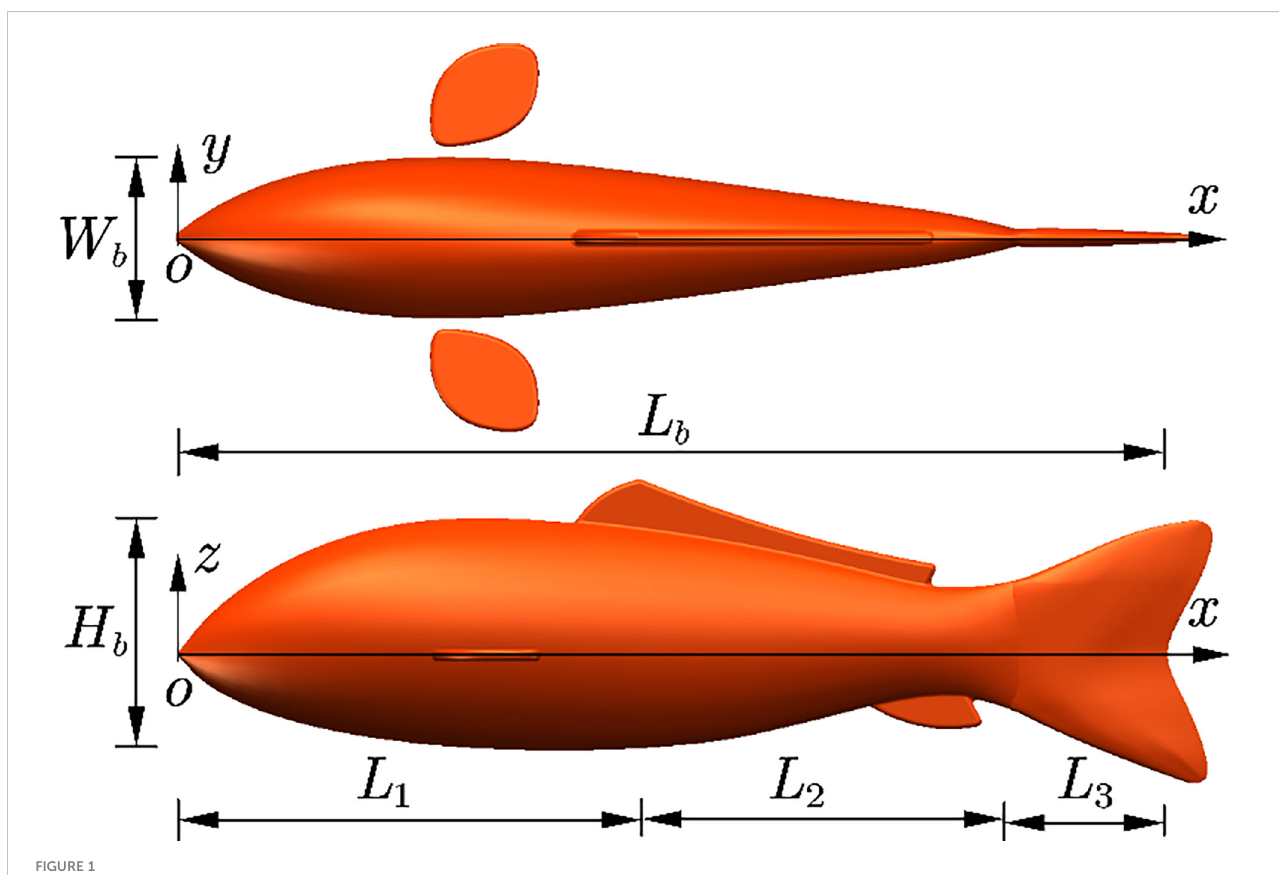
FIGURE 1 3D geometrical model of the fi shlike swimmer. 3D,